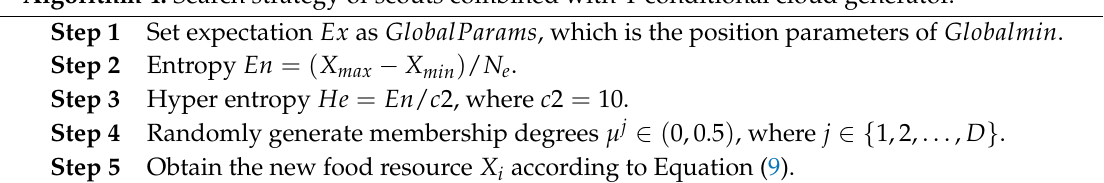
Algorithm 4: Search strategy of scouts combined with Y-conditional cloud